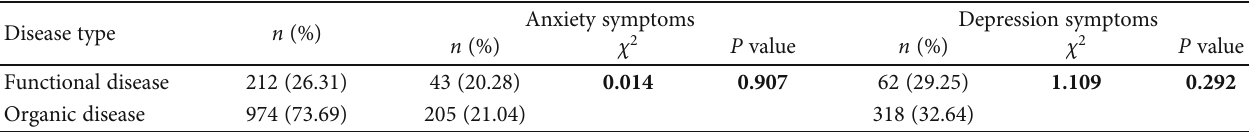
Table 3: Detection rates of patients ’ anxiety and depression symptoms with di ff erent diseases.